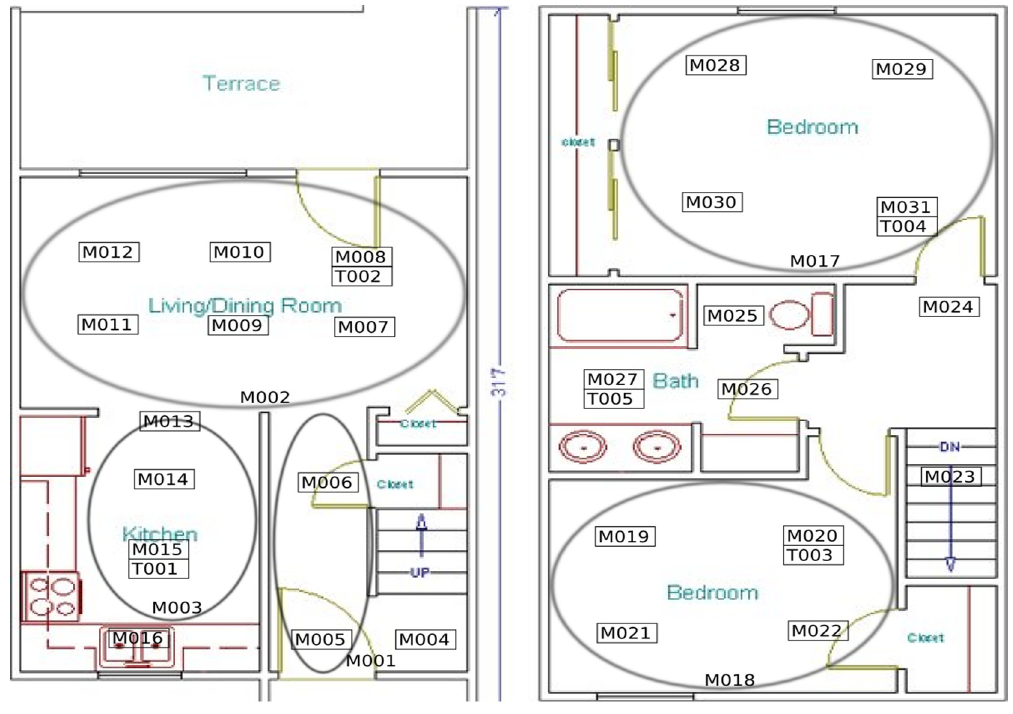
Figure 2. Tulum2010 sensor layout.